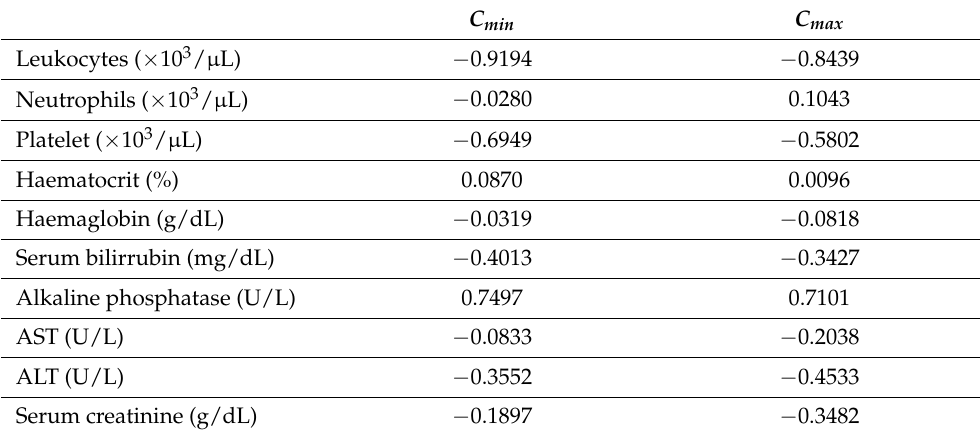
Table 5. Correlation between exposure to nilotinib and developed